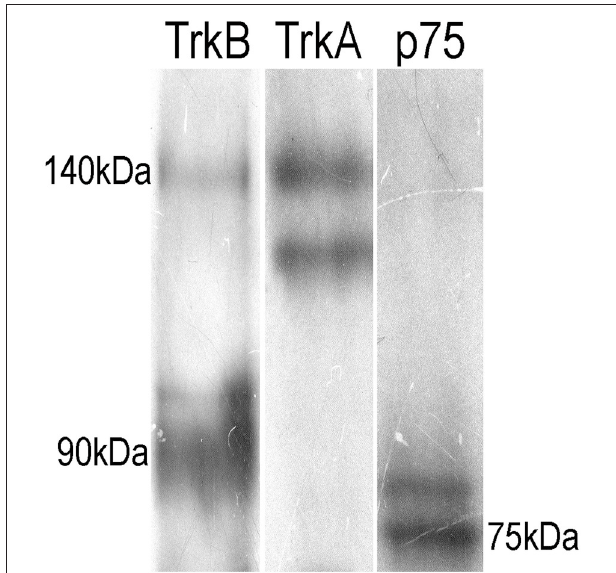
FIGURE 5 | Immunoblotting of adult SCG proteins showing the presence of TrkB (two isoforms), p75NTR, and TrkA. Ganglia were homogenized in lysis buffer, proteins were separated by SDS-PAGE (12.5% resolving gel), and transferred onto a Immobilon-P transfer membrane. Western blot analysis was carried out for Nt receptors. The TrkB-ED antibody revealed the presence of the two isoforms of TrkB, a full-length 140 kD band and a truncated band of 90 kD. The other lanes show the presence of p75NTR (75 kD) and a doublet for TrkA.